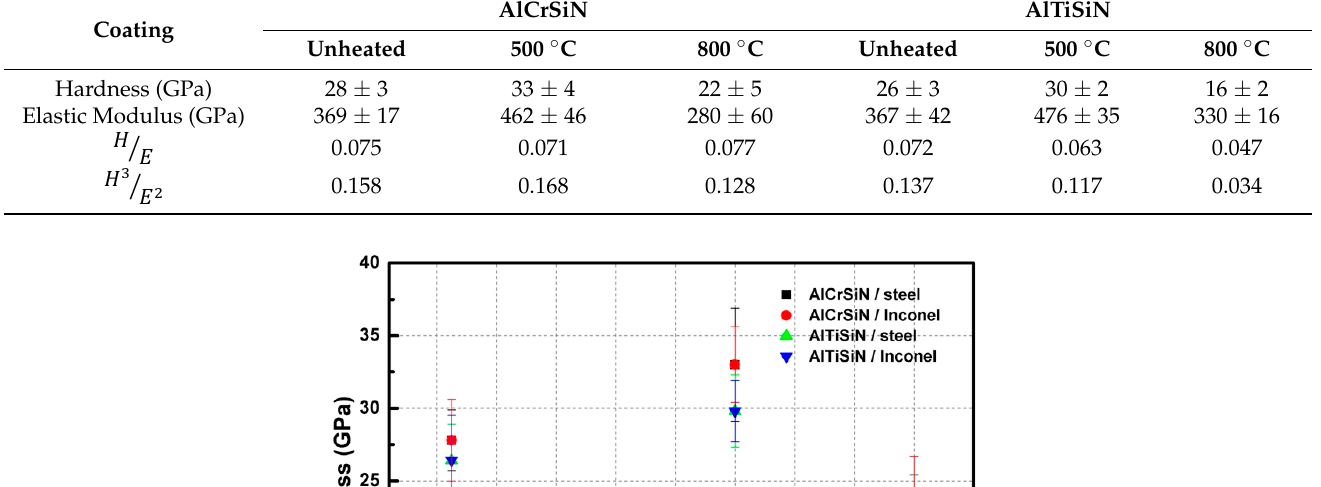
Table 5. Mechanical properties of coated samples after thermal treatment.